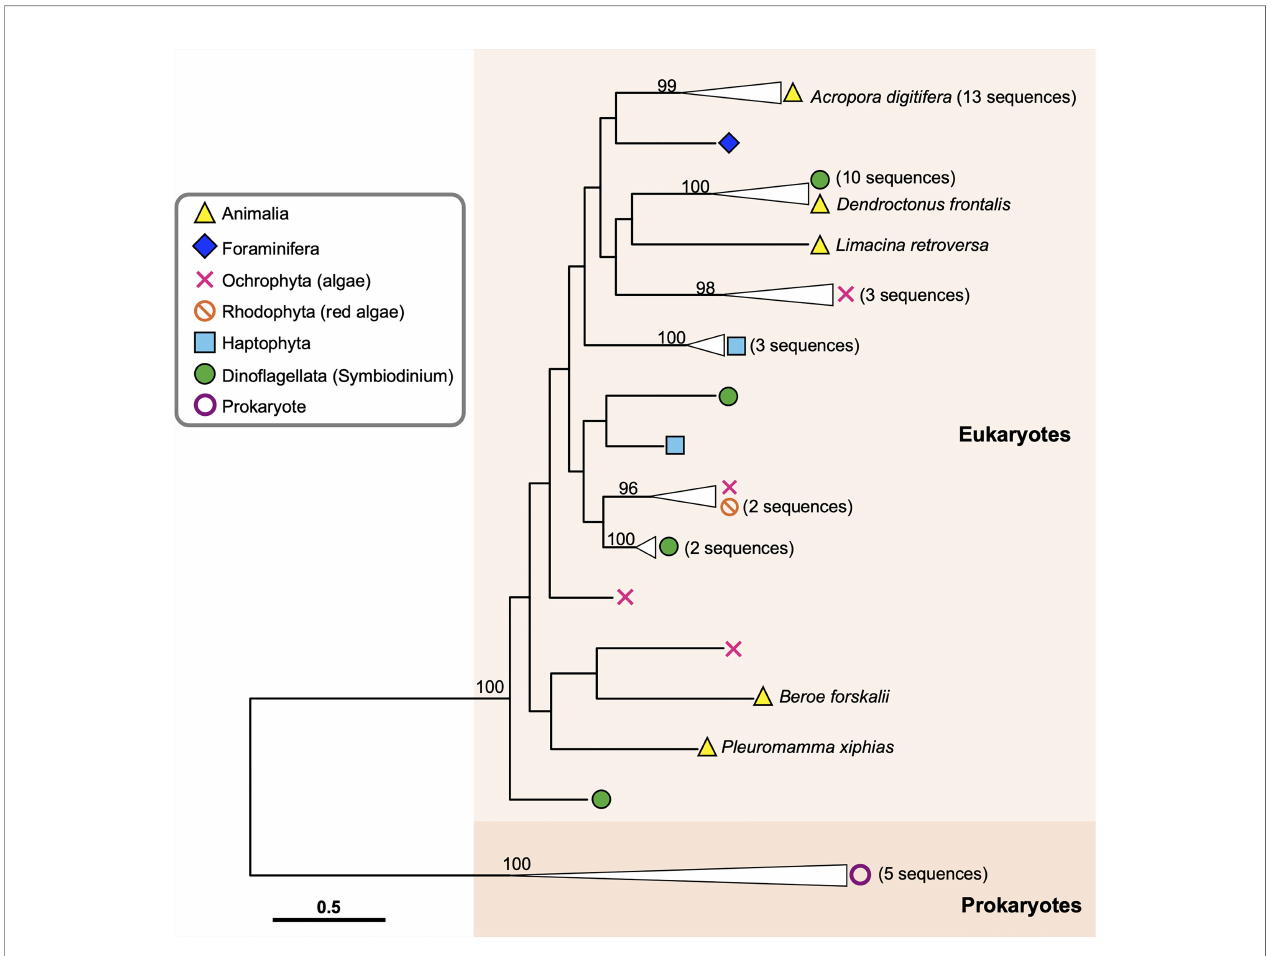
FIGURE 3 | Molecular phylogenetic analysis of DL-L genes identi fi ed from transcriptomic databases of eukaryotes. Possible DL-L genes from eukaryotic NCBI TSA databases were analyzed using the maximum likelihood method. 337 gap-trimmed aligned amino acids were used for phylogenetic analysis. Bootstrap support for representative nodes is shown. Eukaryotic and prokaryotic DMSP lyase genes clades are highlighted in different colors. A. digitifera DL-L genes cloned from cDNA are represented as animal genes in the analysis. DL-L genes from the Animalia, Foraminifera, Ochrophyta, Rhodophyta, Haptophyta, Dino fl agellata, and Prokaryota are colored in yellow (triangle), indigo (diamond), pink (cross), orange (prohibited), blue (square), green (circle), and purple (white circle), respectively. The bar indicates 0.5 substitutions per site in aligned regions. The complete phylogenetic tree is shown in Supplementary Figure 2